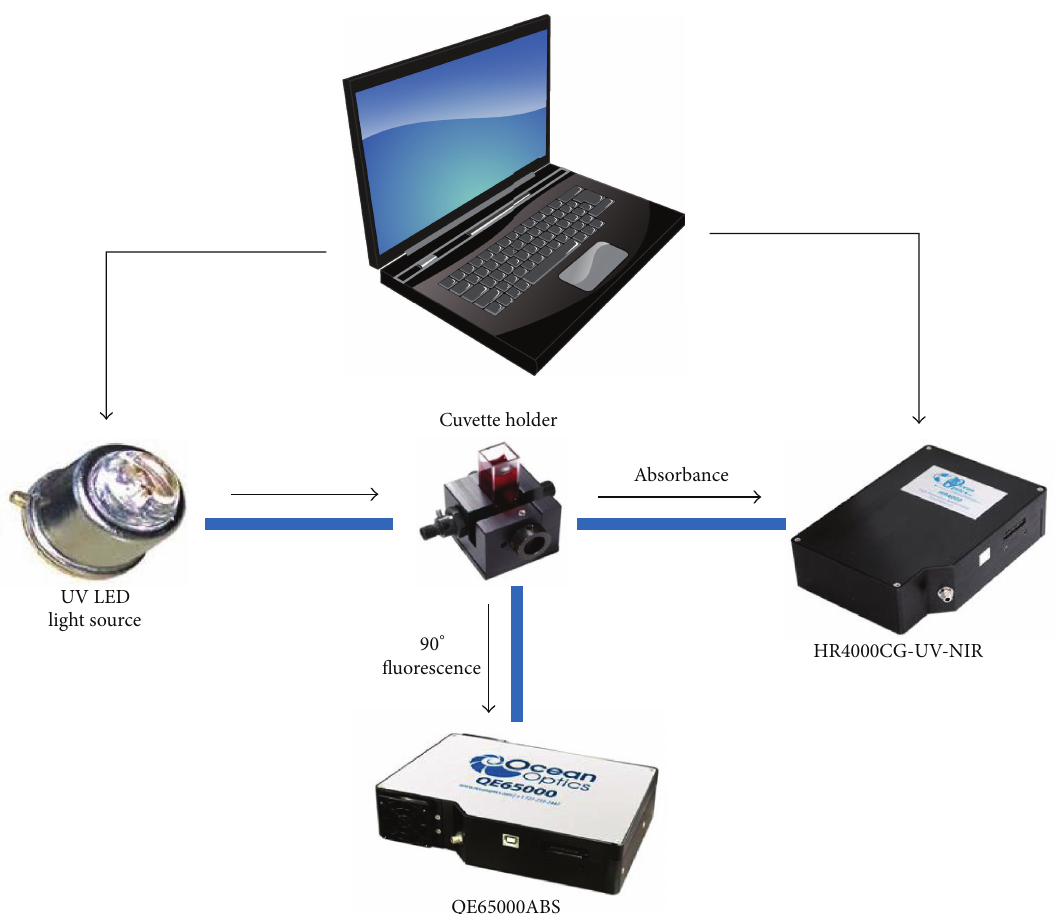
Figure 1: Experimental